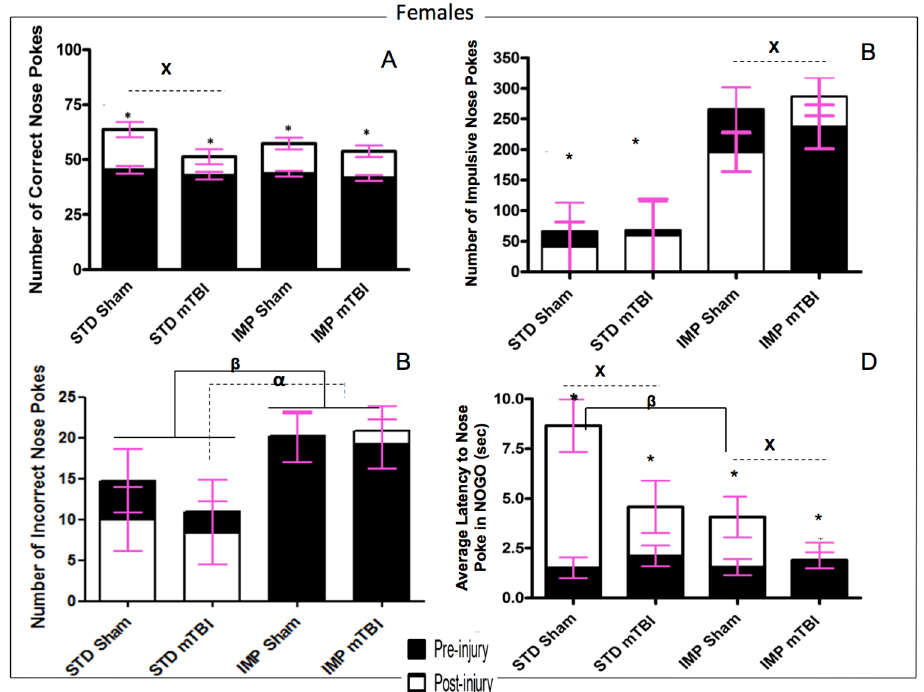
Fig 7. Graphical representation of Go/No-Go results. A) Accuracy, B) Impulsivity, C) Inaccuracy, and D) Response Inhibition, for female animals from the STD and IMP cohorts at the pre-injury (black bars) and post-injury (white bars) test sessions. Overall accuracy increased across all cohorts from the pre-injury session to the post-injury session, but the magnitude of change was greater for sham animals. Similar to males, the STD cohort exhibited a reduction in incorrect nose pokes with increased training but animals in the IMP cohort did not exhibit a change in the number of incorrect nose pokes. STD females exhibited significantly fewer impulsive nose pokes than IMP females at both time points. Finally, also like males, all animals except IMP-mTBIs demonstrated improvements in latency to nose poke on the NOGO trials, but the magnitude was greatest for the STD-shams ( α significant effect of IMP at pre-injury, β significant effect of IMP at post-injury, x significant effect of mTBI, * significant effect of testing period, all p <